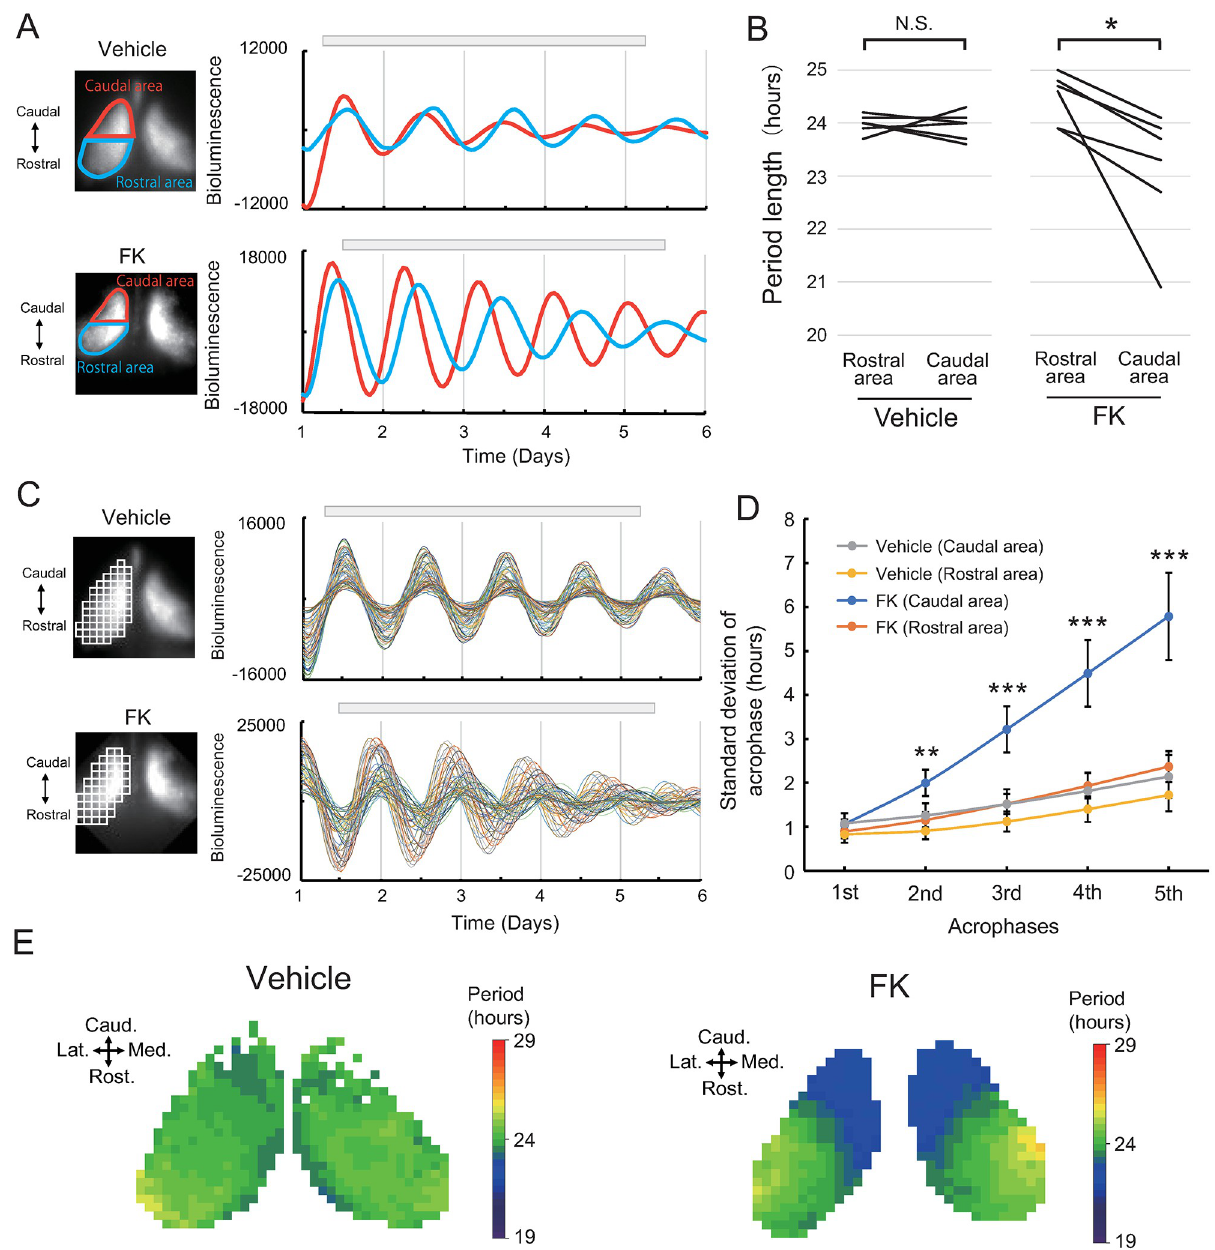
Fig 3. Effect of forskolin on Per2 ::dLuc bioluminescence rhythm. (A) Representative bioluminescence image of the SCN (left) and bioluminescence rhythm (right) of vehicle (upper panel) or FK-treated slices (lower panel). The average bioluminescence intensities of rostral (blue) and caudal (red) areas are plotted against time. Gray bars show the periods for curve fitting. The difference in period length between rostral and caudal areas increased in FK-treated slices. (B) Period lengths of the circadian rhythm in the rostral and caudal areas in the vehicle (n = 6) and FK-treated (n = 6) groups. The mean values of the bioluminescence periods of the rostral and caudal areas of the vehicle group were 24.0 ± 0.06 hours, 23.9 ± 0.1 hours, and in the FK- treated group, 24.1 ± 0.3 hours and 22.7 ± 0.5 hours, respectively (Mean ± SE). Repeated measures two-way ANOVA with post hoc Bonferroni test showed no significant difference between rostral and caudal areas of Vehicle group, but showed a significant difference between rostral and caudal areas of FK-treated group ( � : p < 0.05, N.S.: not significant). (C) Small grids were used to divide the unilateral SCN, and bioluminescence data from all grids were plotted against time. With the vehicle, the period lengths were almost identical. In FK-treated slices, the circadian rhythms showed desynchrony compared with vehicle-treated slices. Gray bar: time used for curve fitting. Grid size: 64 μ m. (D) The standard deviation of acrophase in each (1 st –5 th ) cycle within a single SCN slice (mean ± SE). Acrophase was calculated by the fitted curve obtained from the bioluminescence of each grid. According to multivariate comparison and post-hoc Tukey test, there were significant differences between the rostral area and caudal area in phase variation of the 2 nd –5 th cycles ( �� : p < 0.01, ��� : p < 0.001). (E) The period lengths of the circadian bioluminescence rhythms from grids were calculated by curve fitting. The period lengths of the vehicle-treated slice were similar, whereas the period lengths of the FK-treated slices showed shorter circadian rhythms in the caudal to medial grids than those in other grids. Med: medial, Lat: lateral. Grid size: 32 μ m.